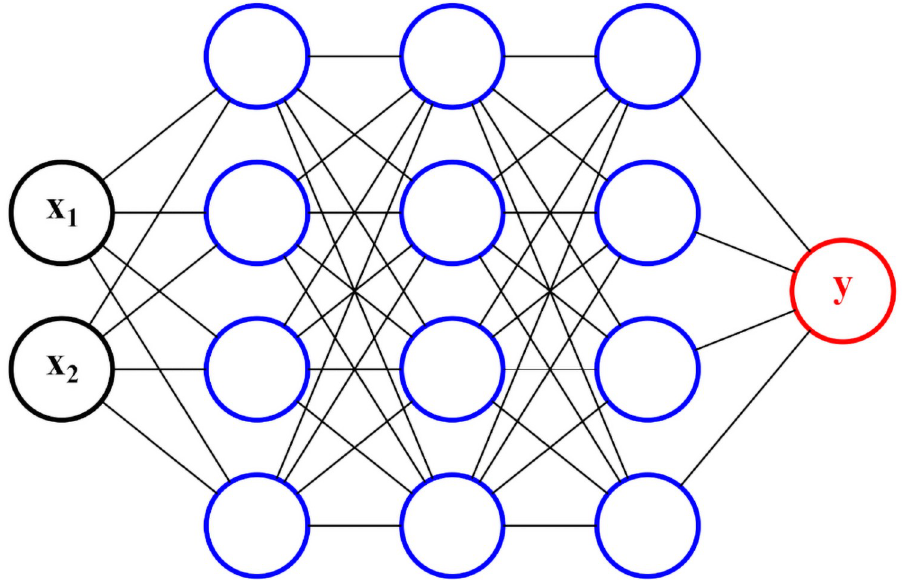
Fig 13. The 4-layer ANN architecture used to classify the Fisher Iris